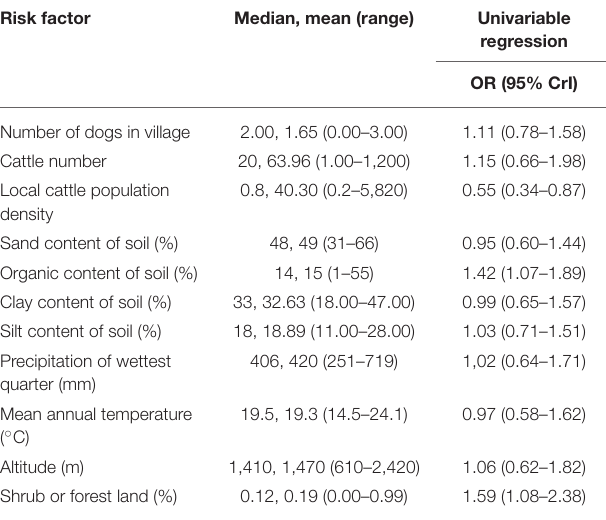
TABLE 2 | Household-level characteristics of continuous variables and their relationship with the seroprevalence of Neospora caninum in northern Tanzania. Risk factor